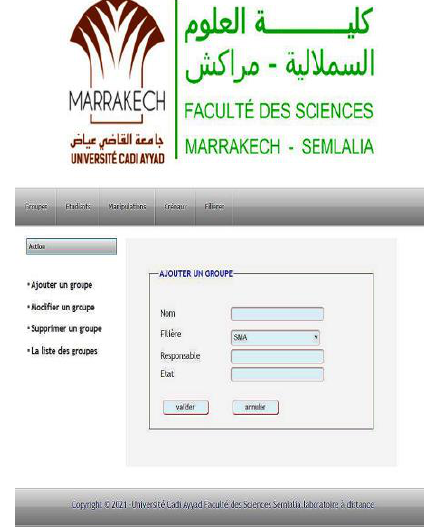
Figure 4. Home page of the platform Figure 5. Teacher